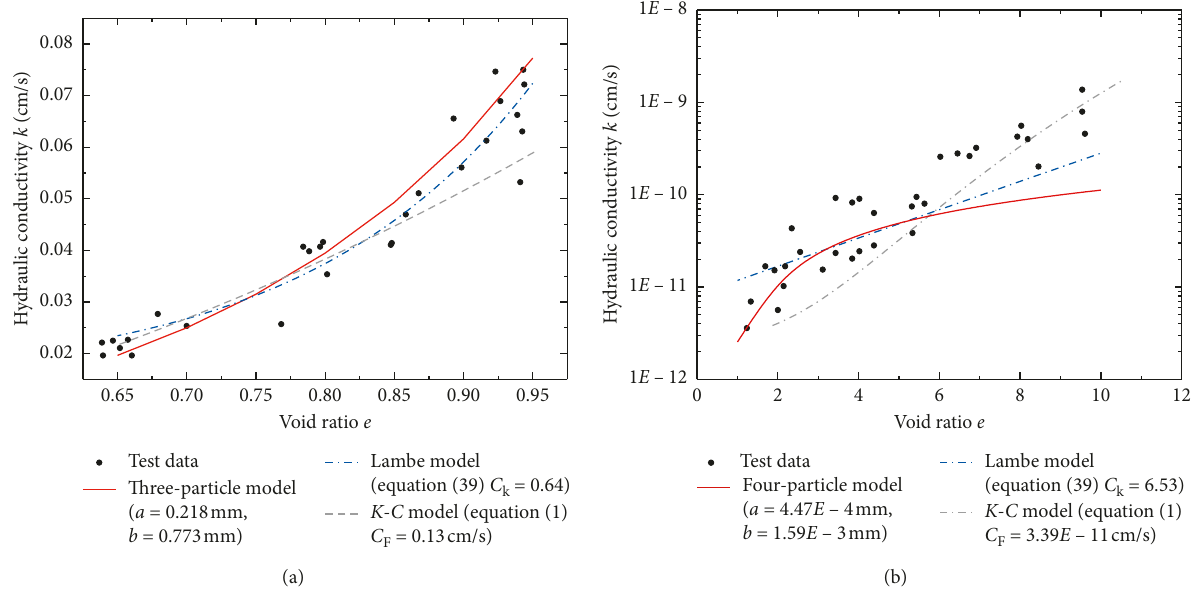
Figure 18: Comparison of different ( k ∼ e ) models. The experimental data of (a) sand soil were measured by Taylor and Donald [42] and the (b) smectite by Mesri